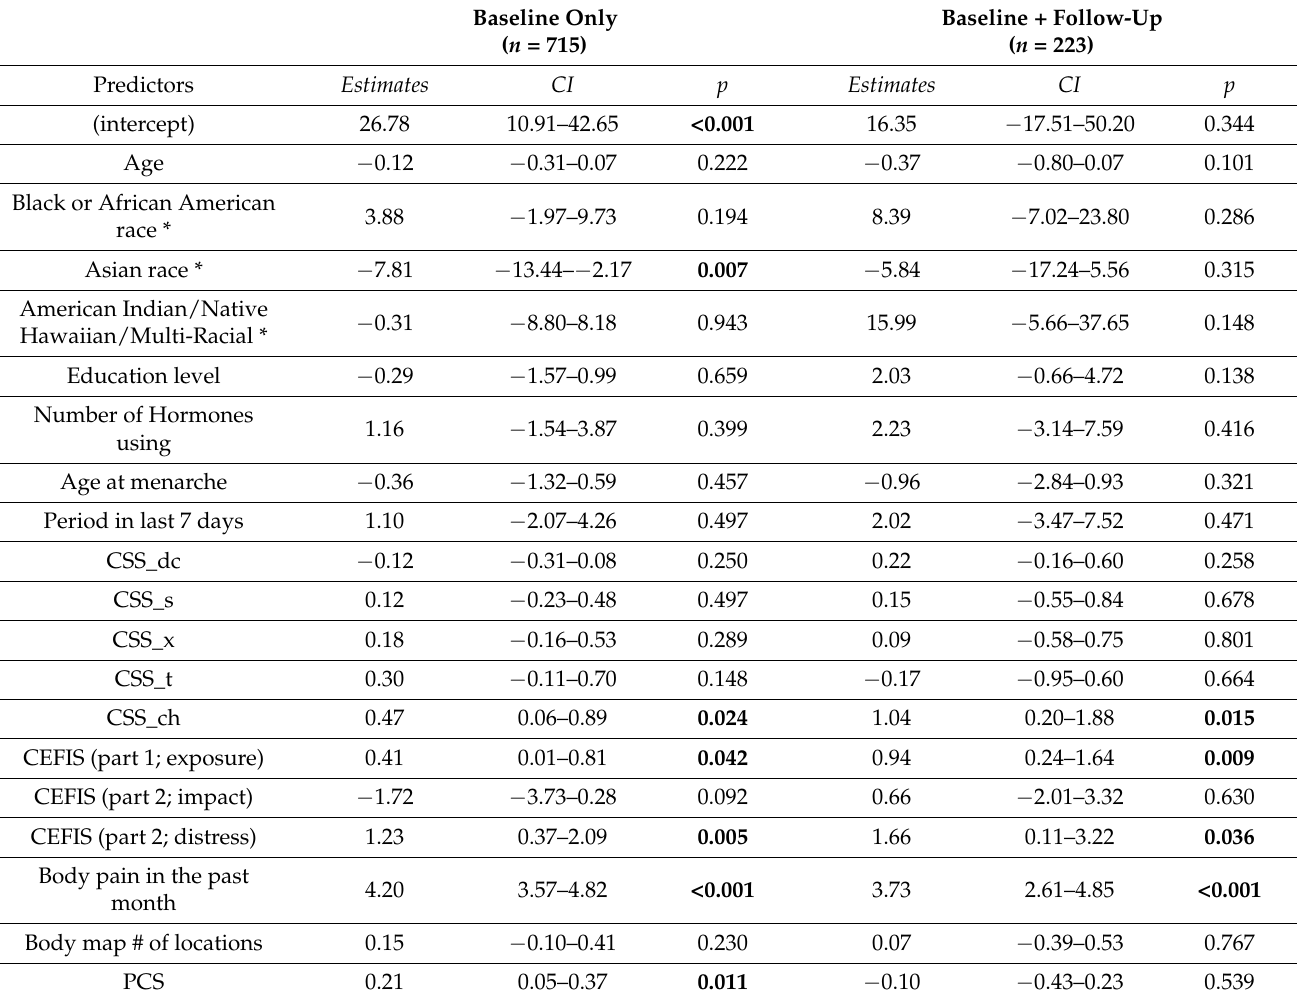
Table 3. Predictors of Menstrual Symptom Severity in participants who completed the baseline assessment only and those who completed both baseline and follow-up assessment.